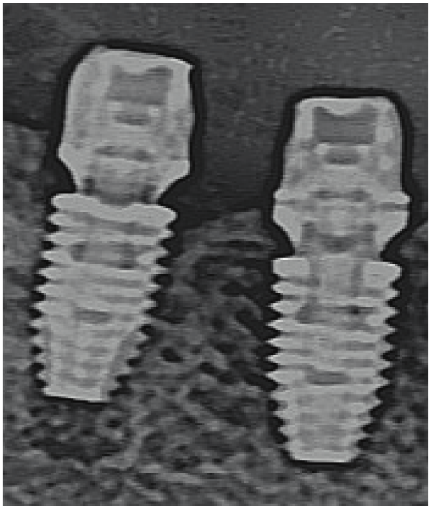
Figure 6: Radiographic control of the fit of the On1 base into the implant during surgery.